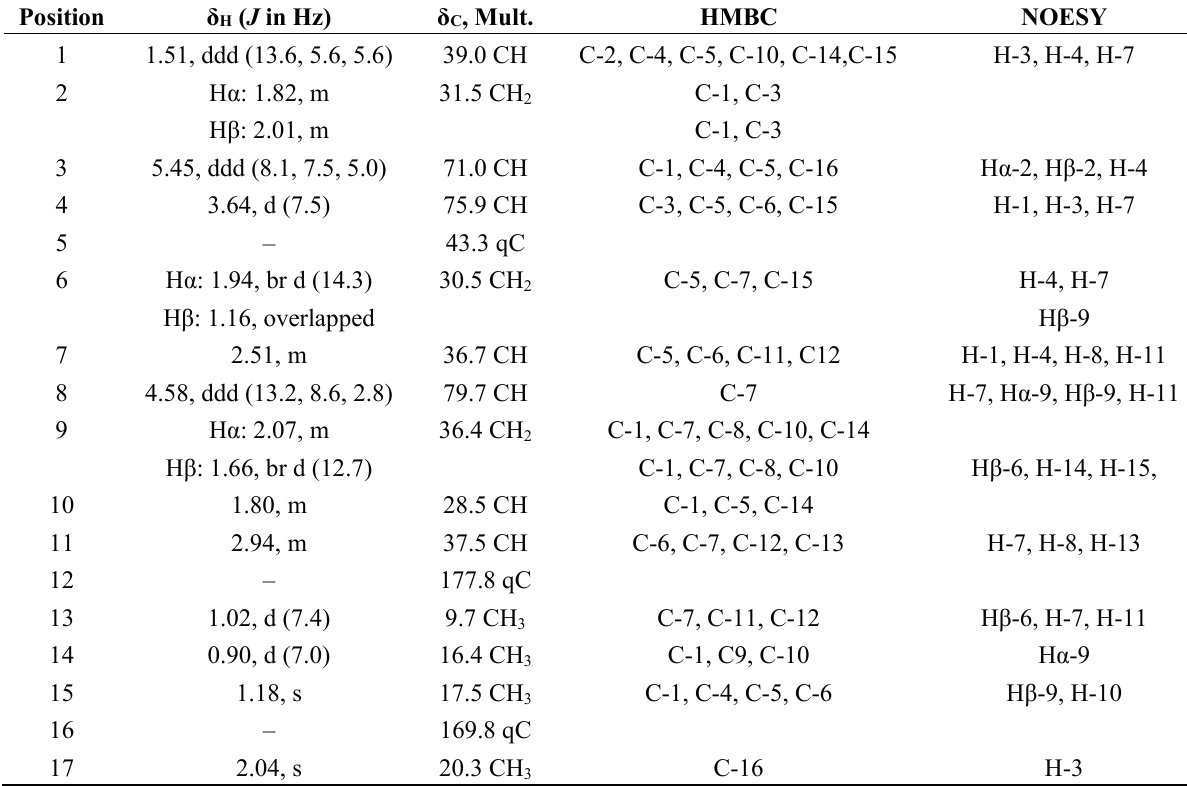
Table 1. NMR assignments of 1 by DEPT, HSQC, HMBC, and NOESY experiments in C 5 D 5 N a